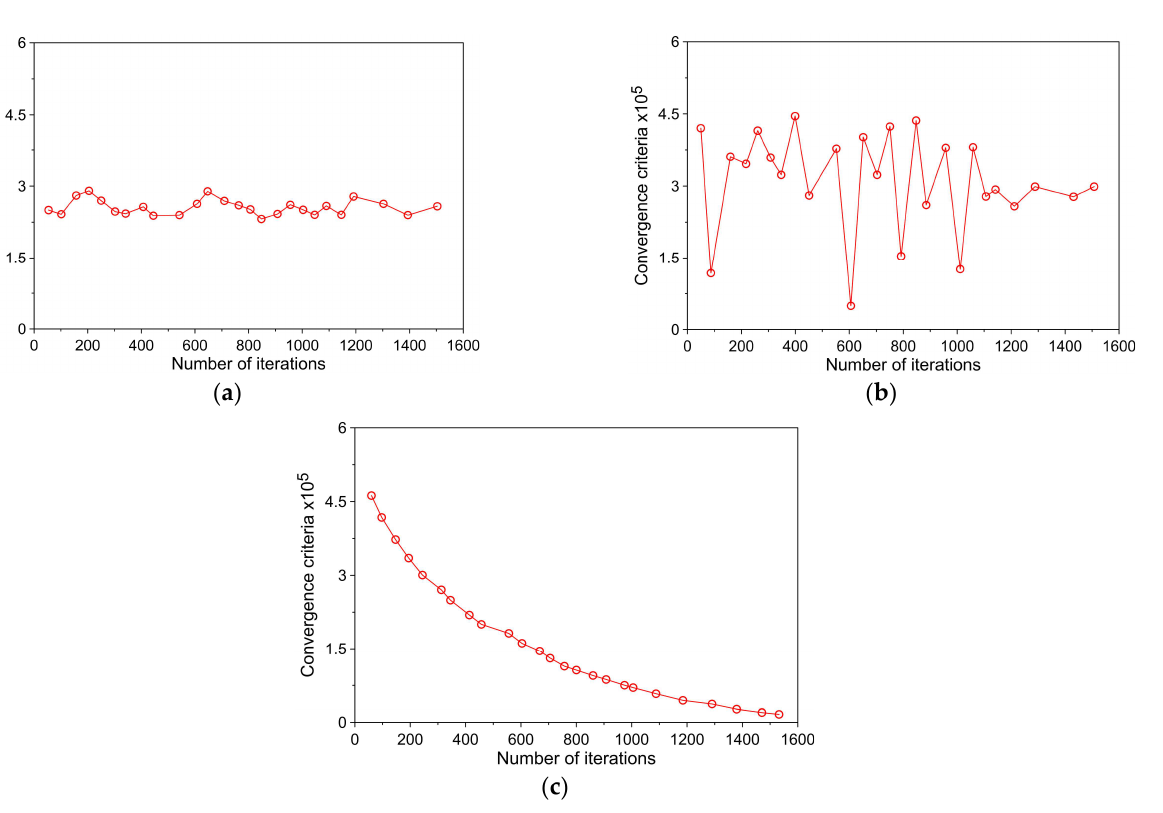
Table 1. Thermodynamic properties of the stainless steel S316L.